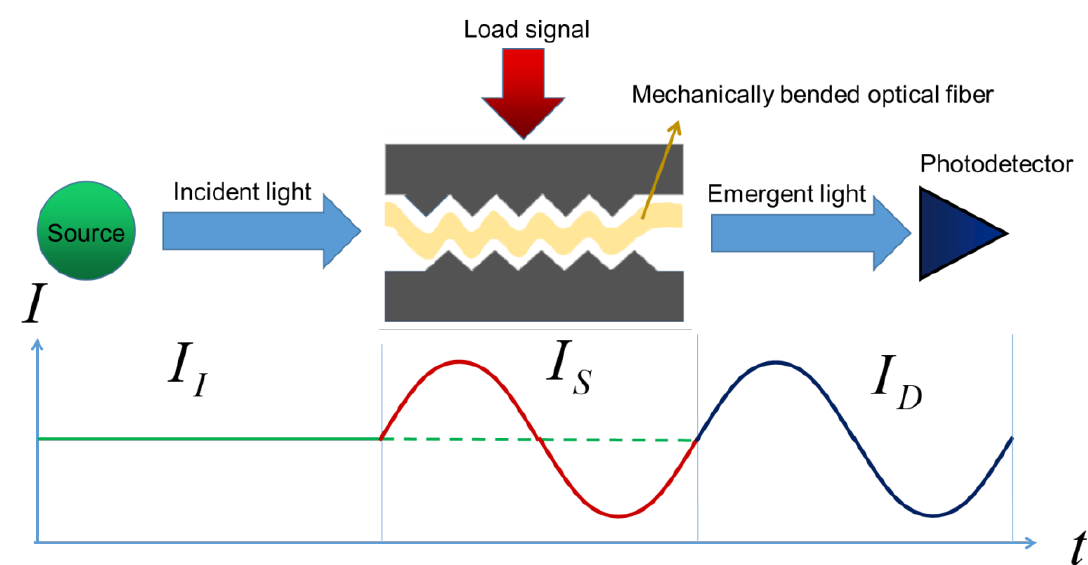
Figure 5. Schematic of micro bend sensor